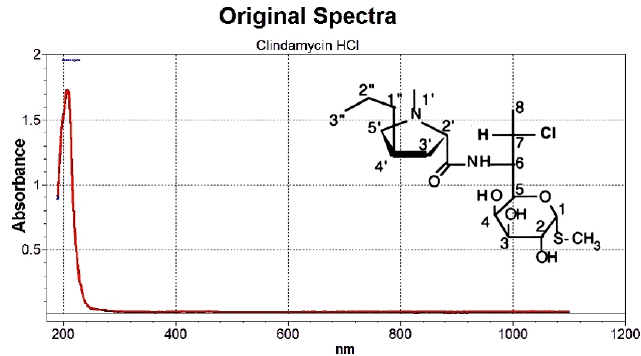
Figure 1. UV spectrum of clindamycin HCl in phosphate buffer pH 7.5.